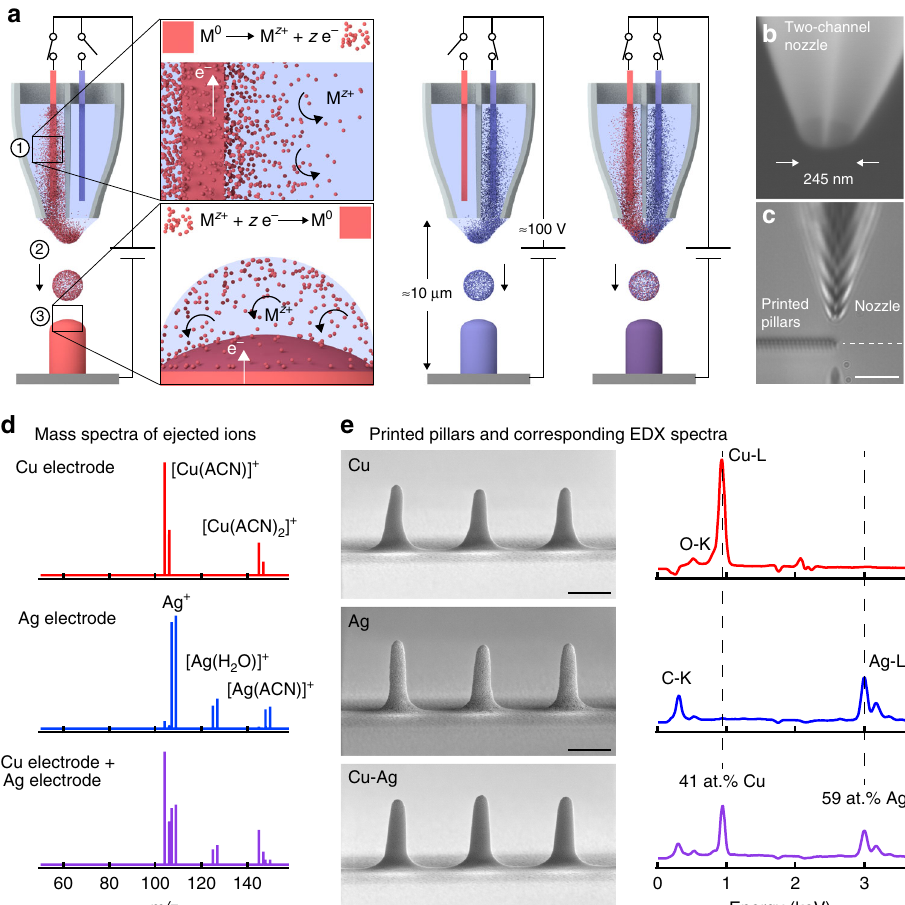
Fig. 1 Electrohydrodynamic redox printing (EHD-RP). a Working principle: (1) Solvated metal ions M z + are generated within the printing nozzle via electrocorrosion of a metal electrode M 0 immersed in a liquid solvent. (2) Ion-loaded solvent droplets are ejected by electrohydrodynamic forces. (3) Upon landing, M z + ions are reduced to zero valence metal M 0 through electron transfer from the substrate. Switching the oxidative voltage between different electrodes in a multichannel nozzle enables on-the- fl y modulation of the printed chemistry (Schematics not drawn to scale: typical dimensions of the electrode wire are 100 μ m × 2 cm). b Typical two-channel nozzle. c Optical micrograph of the printing process. Scale bar: 10 μ m. d , e Printing Cu, Ag